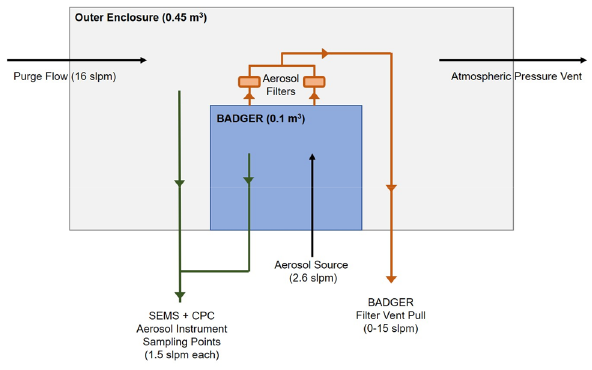
Figure 5. Diagram of the sub-micrometer aerosol particle containment test experimental setup. The BADGER device was fully enclosed in a sealed outer enclosure which was continually purged with particle-free air at 16 standard liter per minute (slpm) and had an open vent port to the room to maintain pressure in the outer enclosure near room pressure. The SEMS and CPC aerosol sampling instruments were valved so that they could independently switch between sampling either the outer enclosure or the